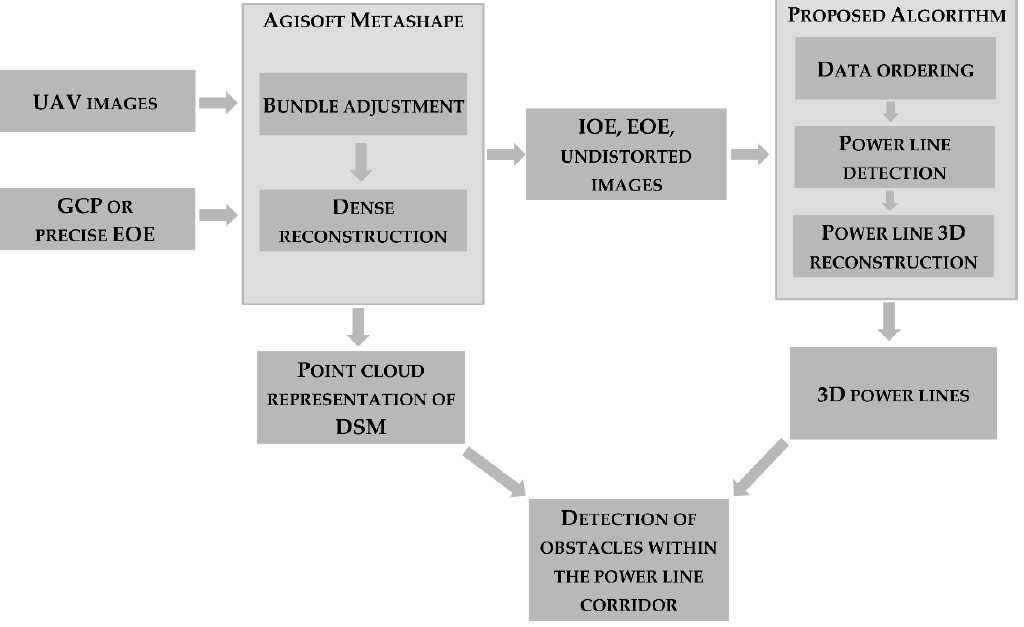
Figure 2. A general schema of the proposed method.